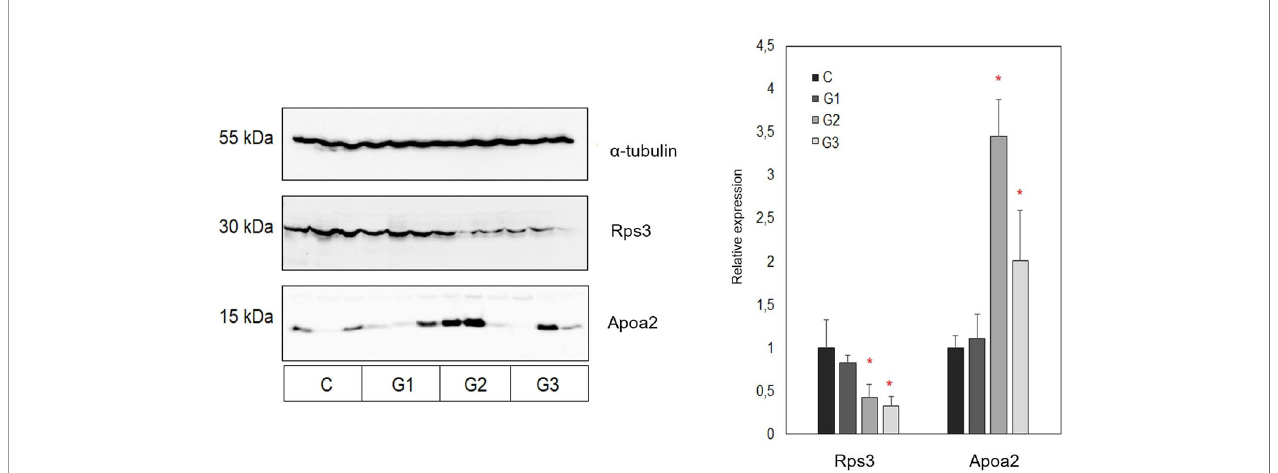
FIGURE 5 | Representative Western blot and summary representation of relative expression of Rps3 and Apoa2 in tumor tissues obtained from control and three treated groups of animals (each group included tumors obtained from three different animals). Results are presented as relative expression values ± SEM between chemiluminescent signals obtained in three replicate experiments. Statistically signi fi cant changes (ANOVA, p < 0.05) are marked with an asterisk. C, control group of animals; G1, AG.1; G2, AG.1 and 5-FU; G3,